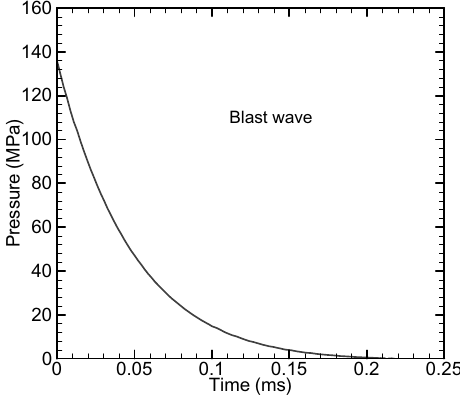
Fig. 8. Reflected pressure exerted on the blast wave mitigation/control device.